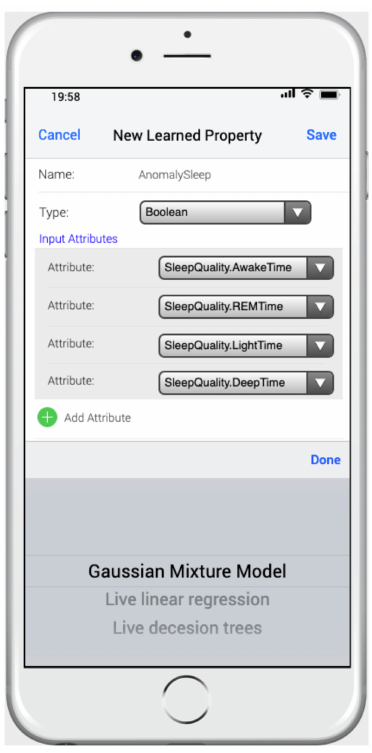
Figure 13. Web app for the MoSIoT scenario